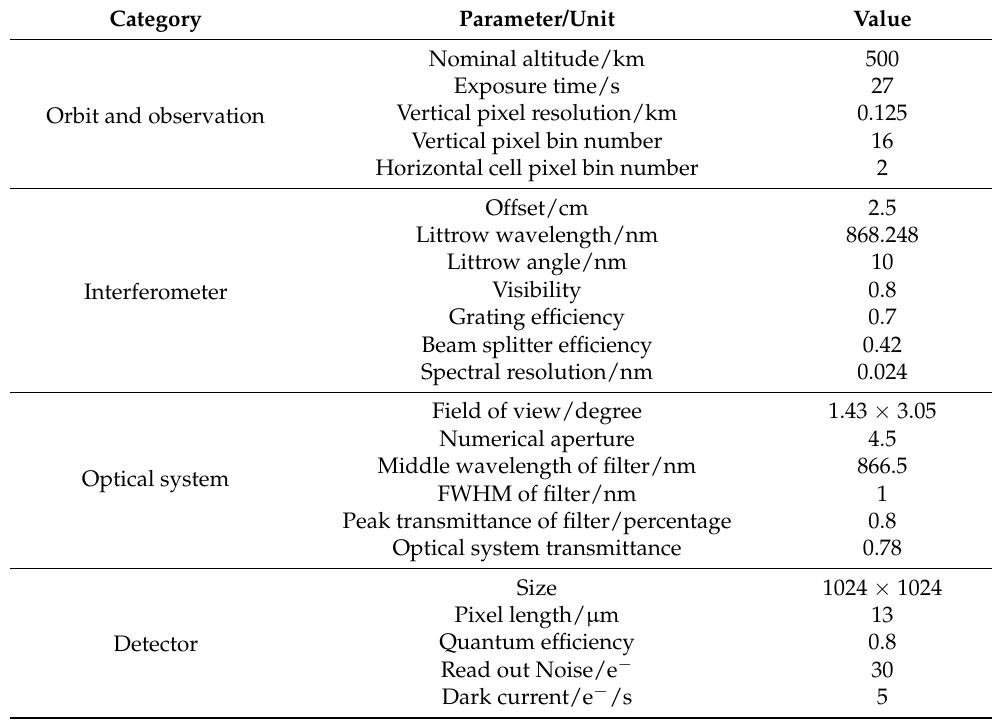
Table 1. The basic parameters of the MWII. Category Parameter/Unit Value Nominal altitude/km 500 Exposure time/s Vertical pixel resolution/km Orbit and observation